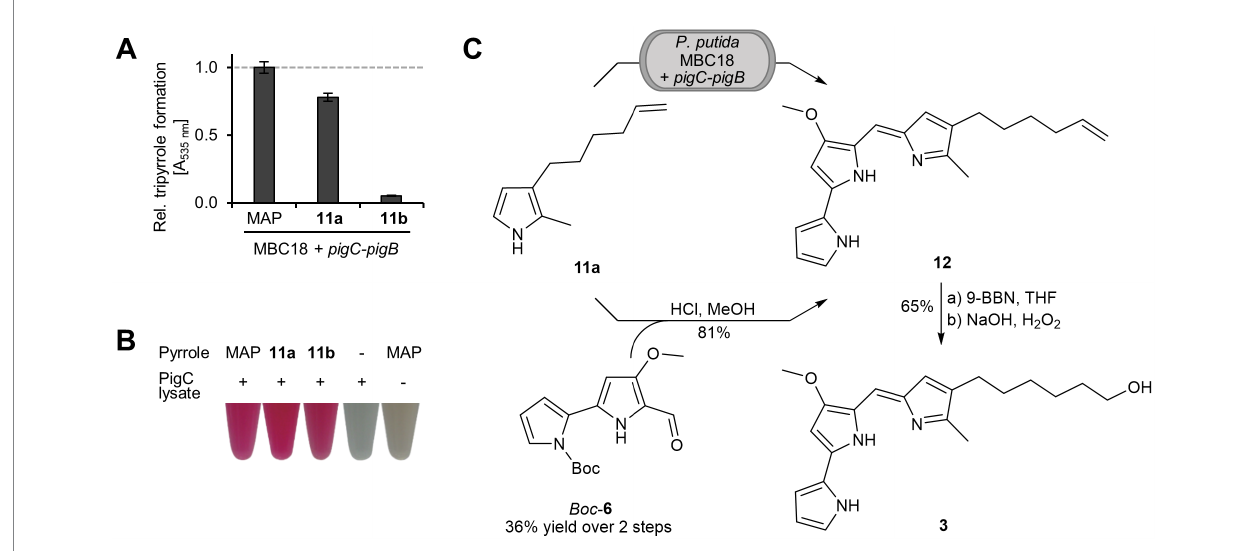
FIGURE 4 Synthetic route toward hydroxylated prodiginine 3. (A) Mutasynthetic tripyrrole formation upon feeding of 11a and 11b , respectively, in small scale cultivation of P. putida MBC18/pVLT33-pigC–pigB. The products were detected spectrophotometrically and quantified relative to the signal upon MAP ( 5 ) supplementation. Mean values of triplicate measurements with the respective standard deviation are shown. (B) Assessment in vitro of PigC substrate acceptance, shown as tripyrrole-typical coloration of reaction mixtures after incubation of lysate from PigC-expressing E. coli cells with MBC ( 6 ) and monopyrroles. (C) Synthesis scheme of hydroxylated prodiginine 3 . Pyrrole 11a was supplemented to the MBC producing strain P. putida MBC18/pVLT33-pigC–pigB in preparative mutasynthesis to obtain the product 12 . As reference, the compound was also synthesized chemically in a condensation reaction with Boc -protected MBC ( 6 ). By the following semisynthetic hydroboration step, the final hydroxylated prodiginine 3 could be